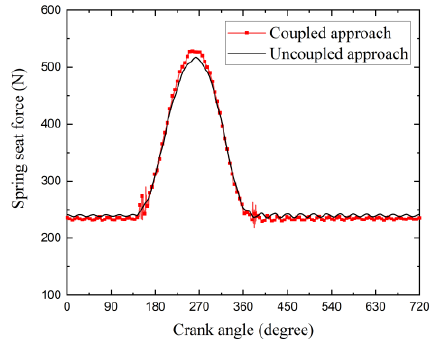
Figure 25. The spring force comparison between the two approaches.